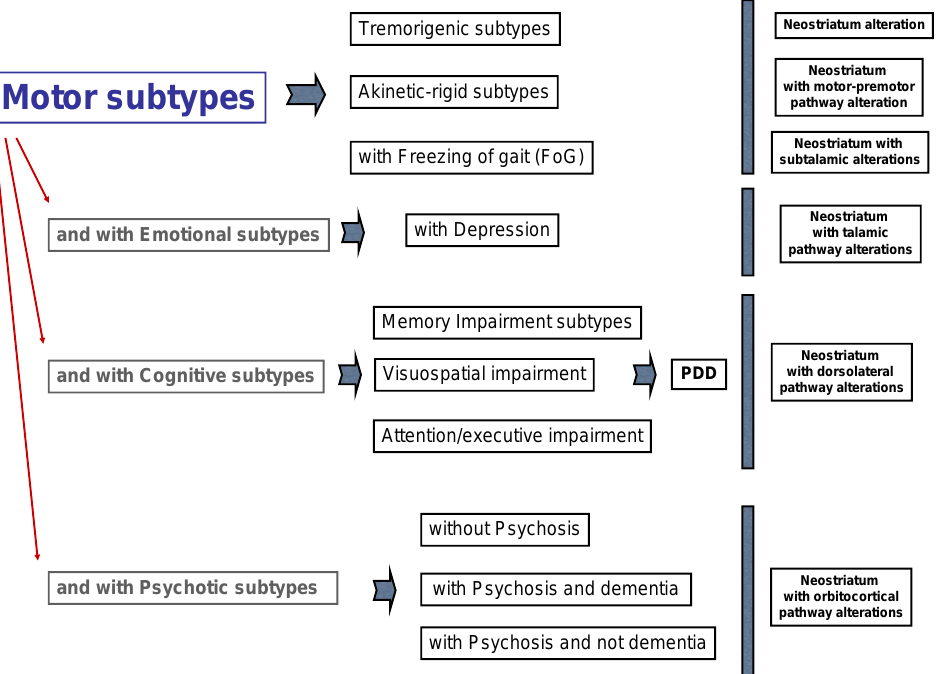
Figure 4. Types of Parkinson’s disease (PD) integrating motor and non-motor symptoms and fronto-striatal circuit altera- tion.